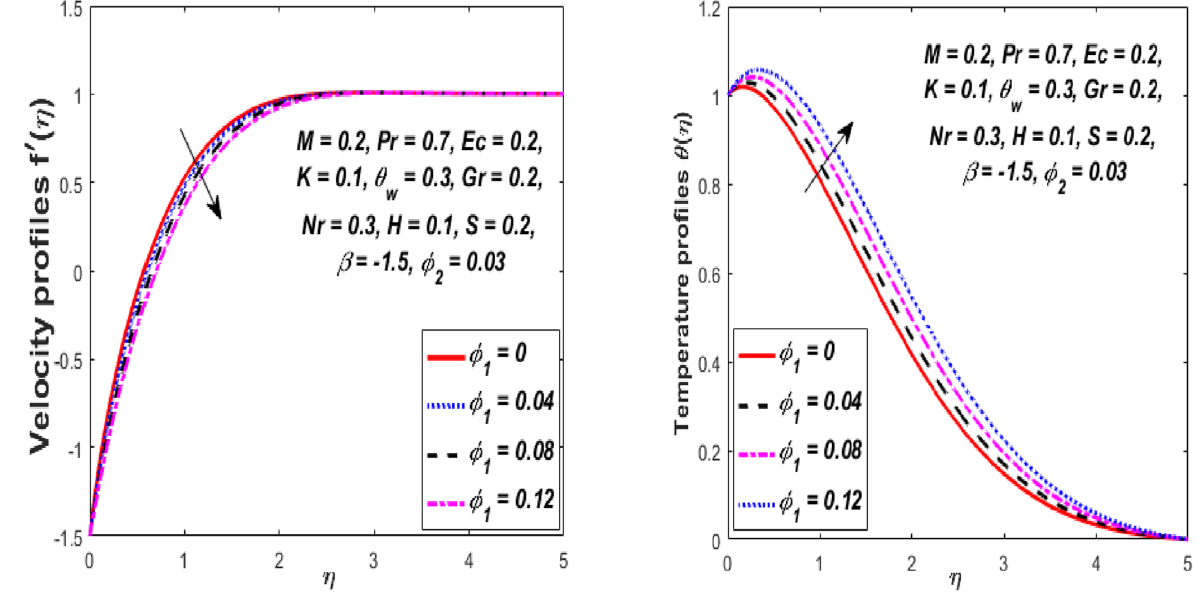
Figure 11. Influence of φ 1 on velocity f ′ (η) and temperature θ(η) profiles.